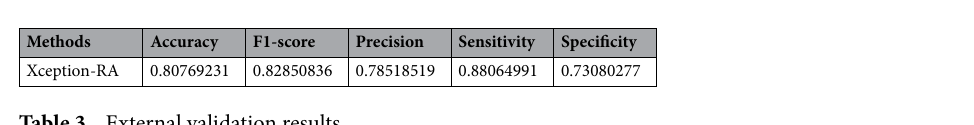
Table 3. External validation results.